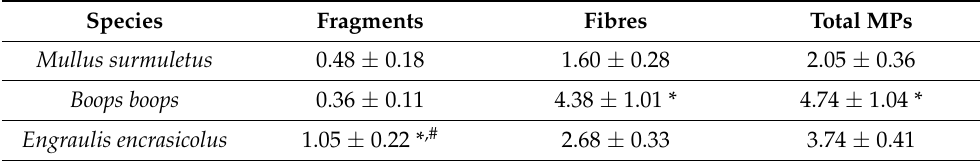
Table 2. Microplastic intake for each of the studied bioindicator species. Species